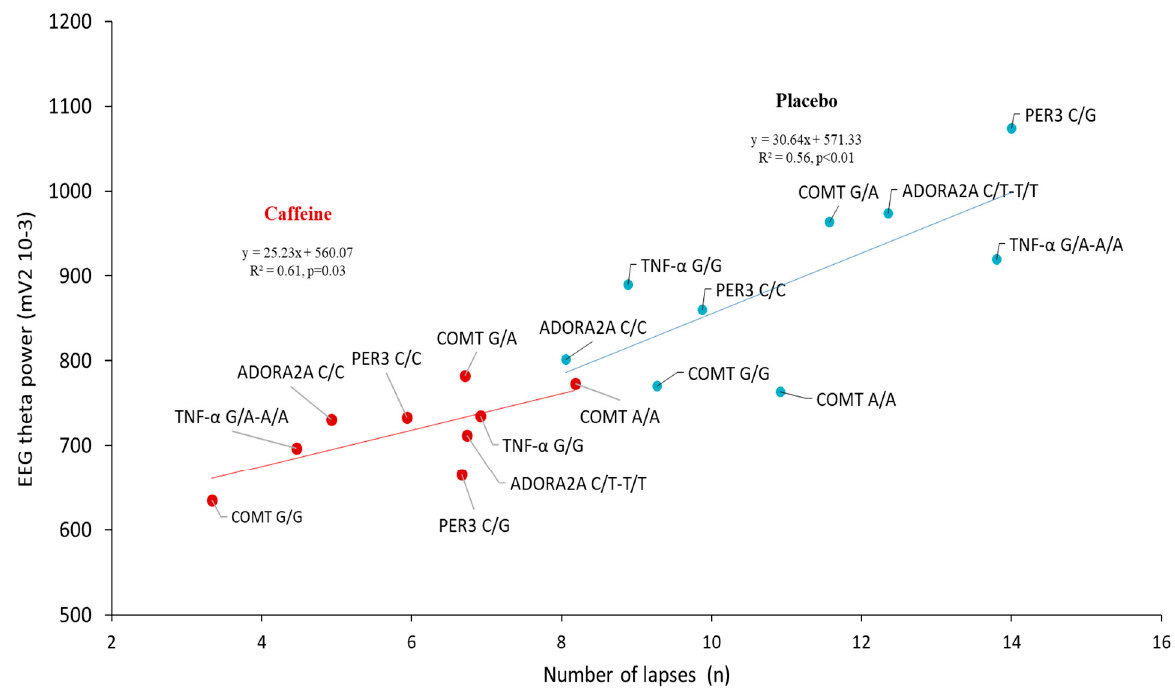
Figure 5. Correlation analysis at 26-h of prolonged wakefulness (D2 day at 09:15) between EEG theta power in the centrotemporal brain region and the number of lapses during the PVT for all genetic polymorphisms in placebo (blue circle, grey line) and caffeine (red circle, black line) conditions.